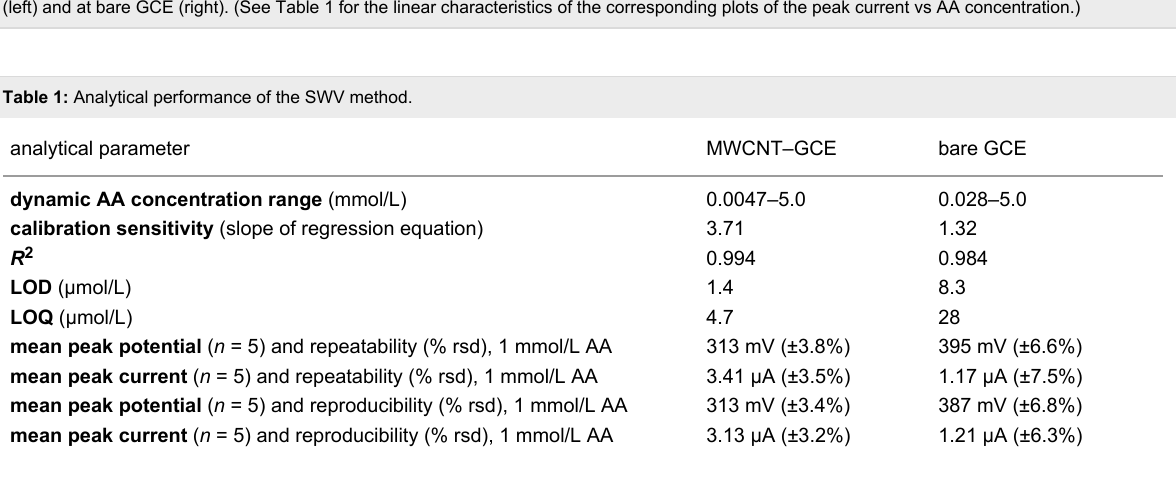
Figure 4: SWV in increasing AA concentrations (0.25–5.0 mmol/L in 0.1 M acetate buffer, pH 3.7); scan rate = 75 mV/s; at MWCNT–GCE electrode (left) and at bare GCE (right). (See Table 1 for the linear characteristics of the corresponding plots of the peak current vs AA concentration.)